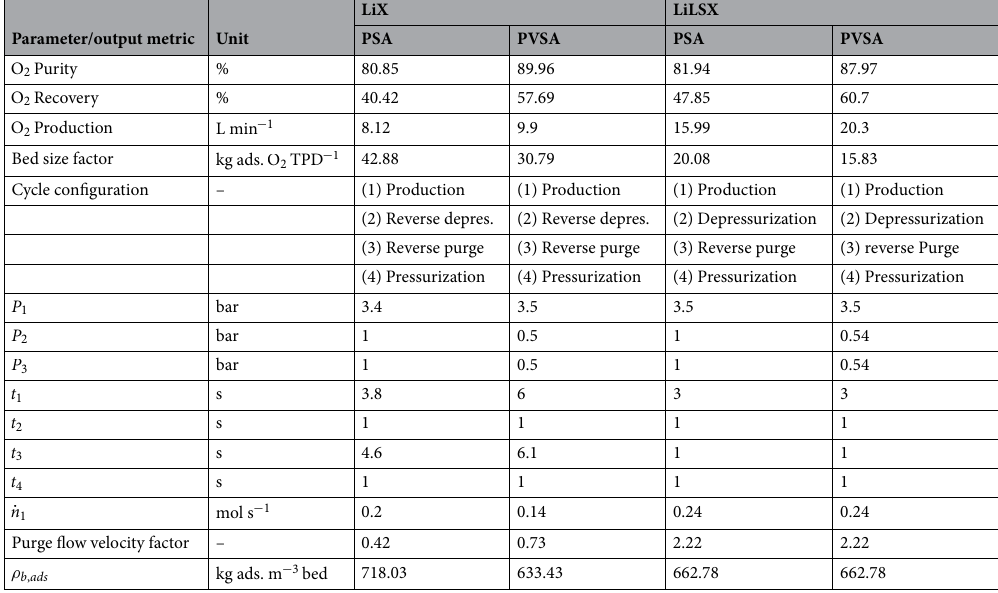
Table 3. Initial guess for optimization case